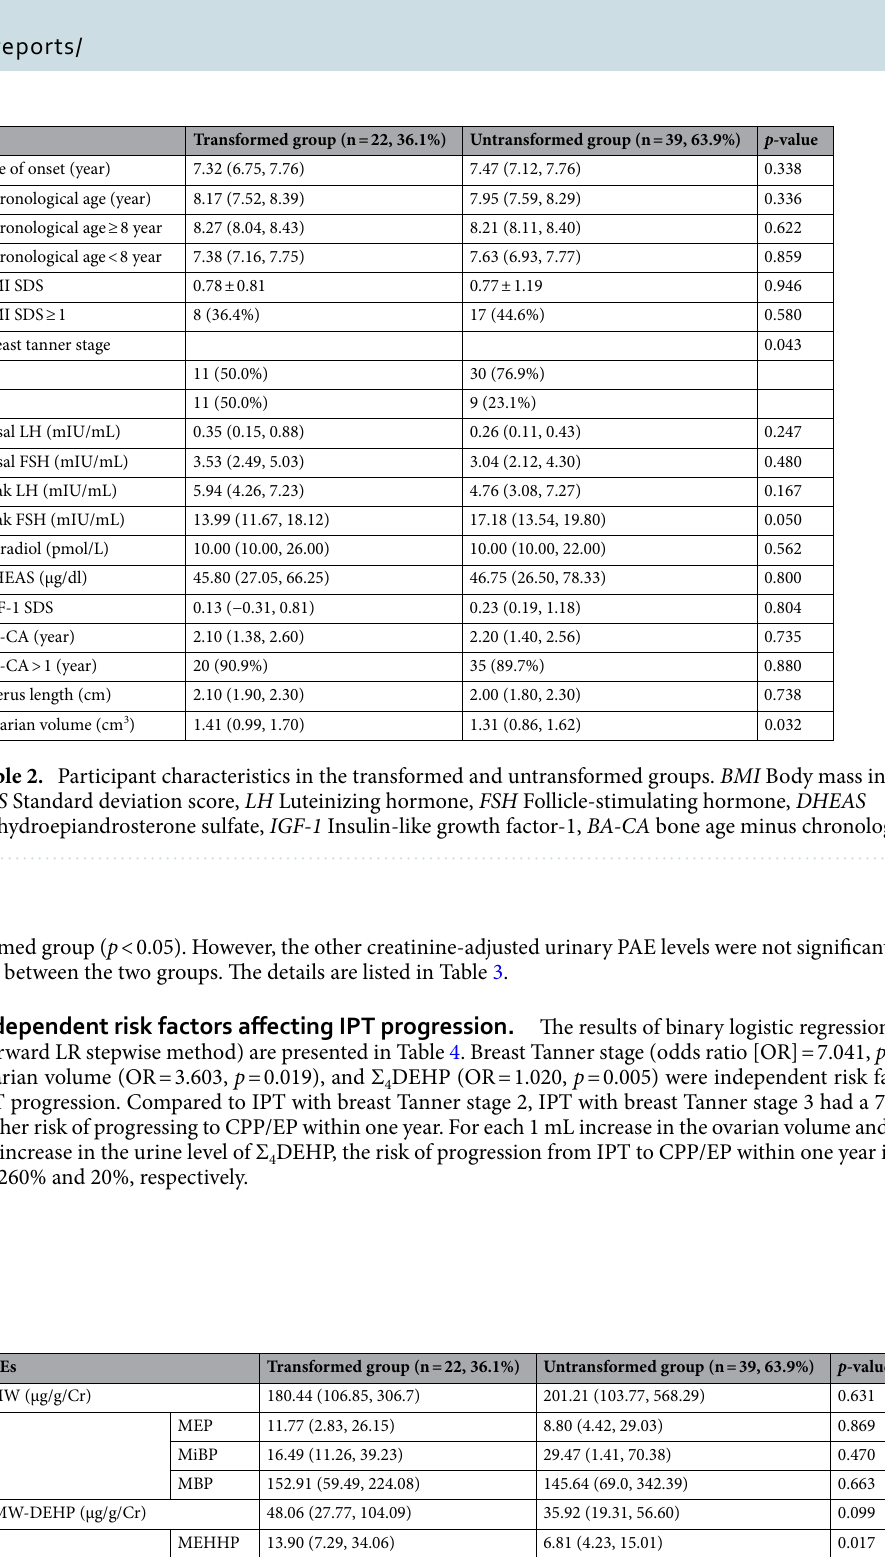
Table 3. Differences in PAE levels between the transformed and untransformed groups. PAEs Phthalate esters, LMW Low molecular weight, MEP Monoethyl phthalate, MiBP Monoisobutyl phthalate, MBP Mono-n-butyl phthalate, HMW-DEHP High molecular weight di-(2-ethylhexyl) phthalate, MEHHP Mono (2-ethyl-5- hydroxyhexyl) phthalate, MEOHP Mono-(2-ethyl-5-oxohexyl) phthalate, MCMHP Mono-[(2-carboxy